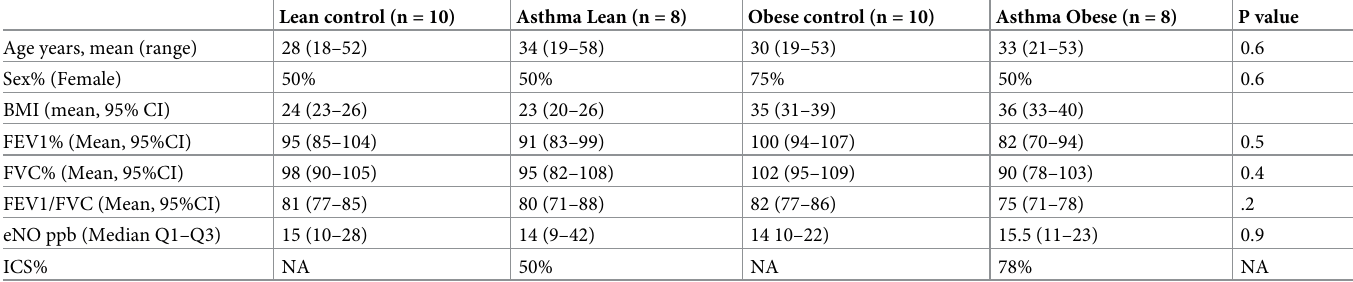
Table 1. Characteristics of the study population. Group differences were tested using t-tests and one-way ANOVAs. Wilcoxon or Kruskall Wallis tests were used to compare non-parametric distributions between two or more groups to compare group differences.